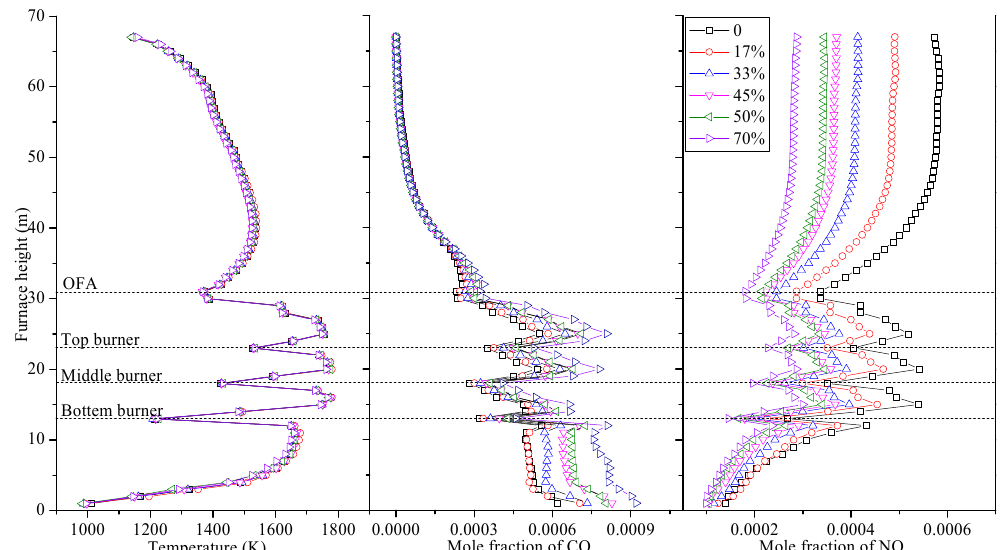
Figure 6. The average temperature and species concentrations along the height of the furnace at various semi-coke blending ratios.